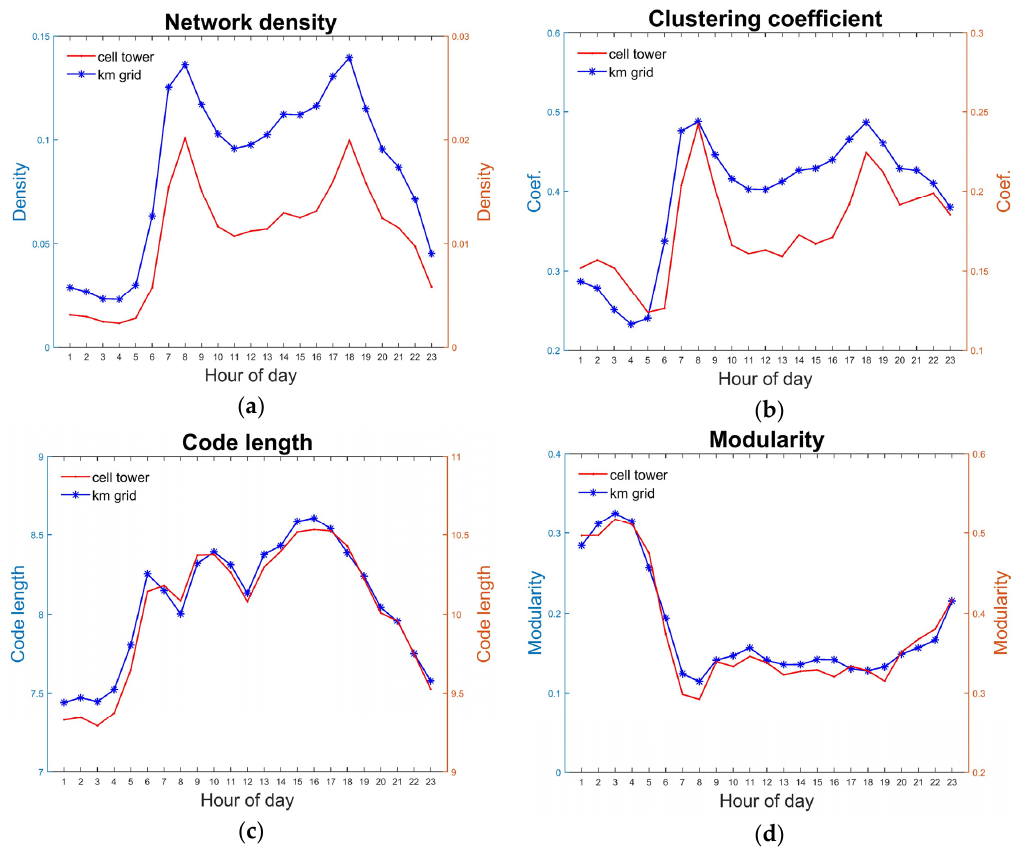
Figure 9. Temporal variations using different spatial units in: ( a ) network density; ( b ) clustering coefficient; ( c ) code length from Infomap; and ( d ) modularity.